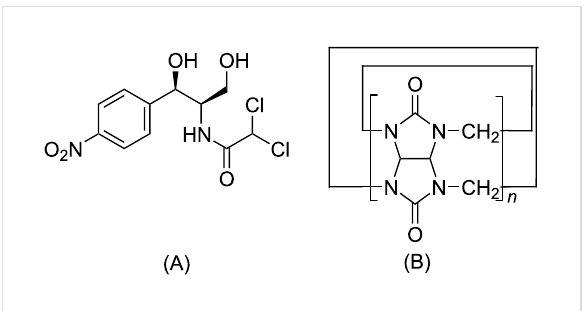
Figure 1: The structures of chloramphenicol (A) and cucurbit[ n ]urils (B).